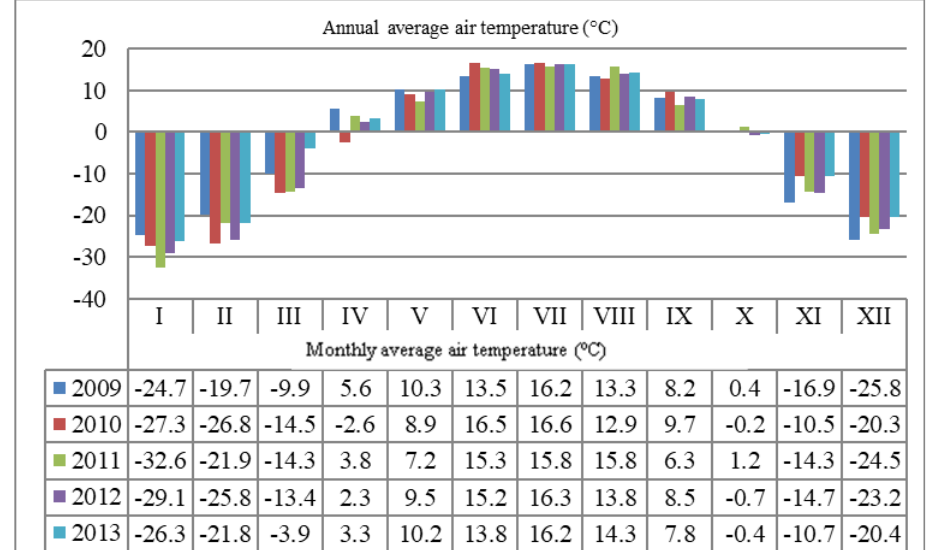
Figure 2. Monthly average air temperature at Jargalant meteorological